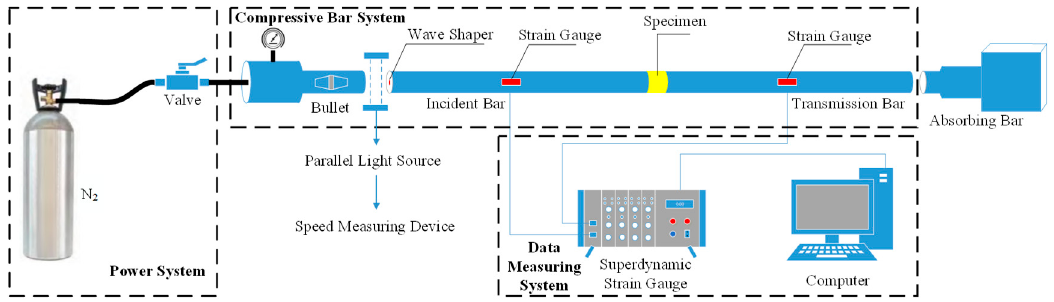
Figure 2. Diagram of SHPB system.